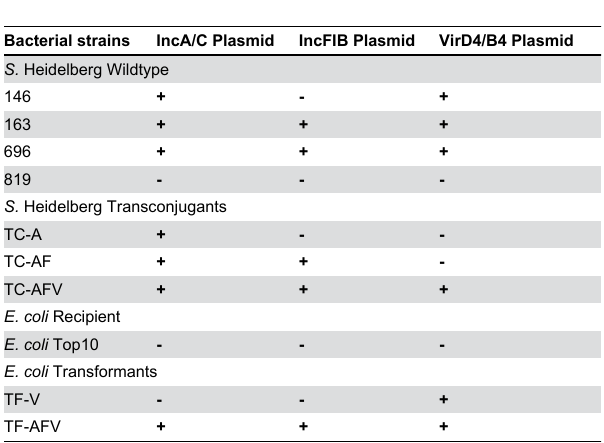
Table 1. Bacterial strain identities and plasmid content of strains used in this